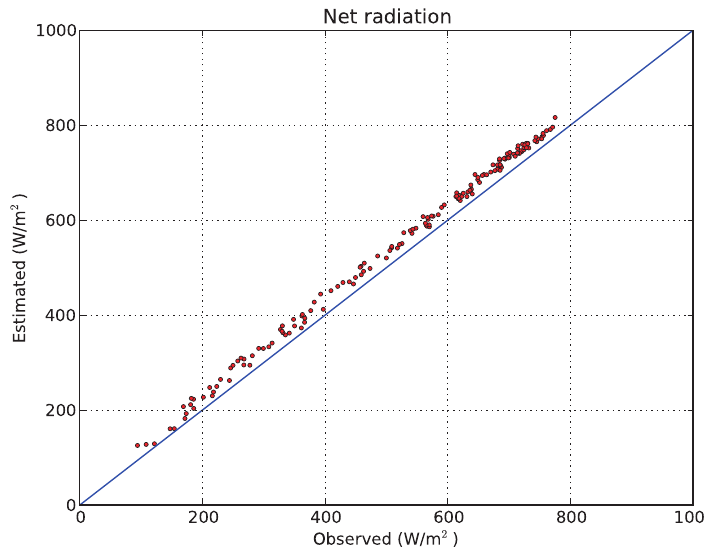
Figure 9. Scatter plot of measured and estimated net radiation from the 30 June to the 14 July 2008 at the Yingke station. RMSE = 32 W/m 2 .